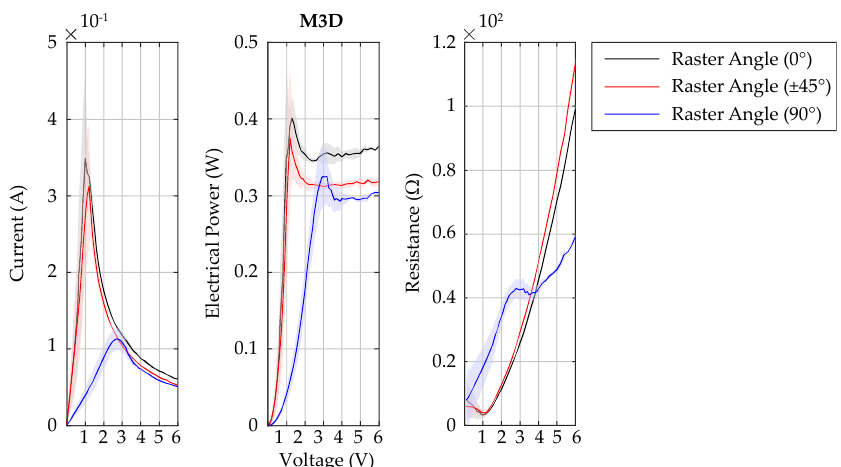
Figure 20. Representation of current, electrical power and resistance depending on voltage of M3D.